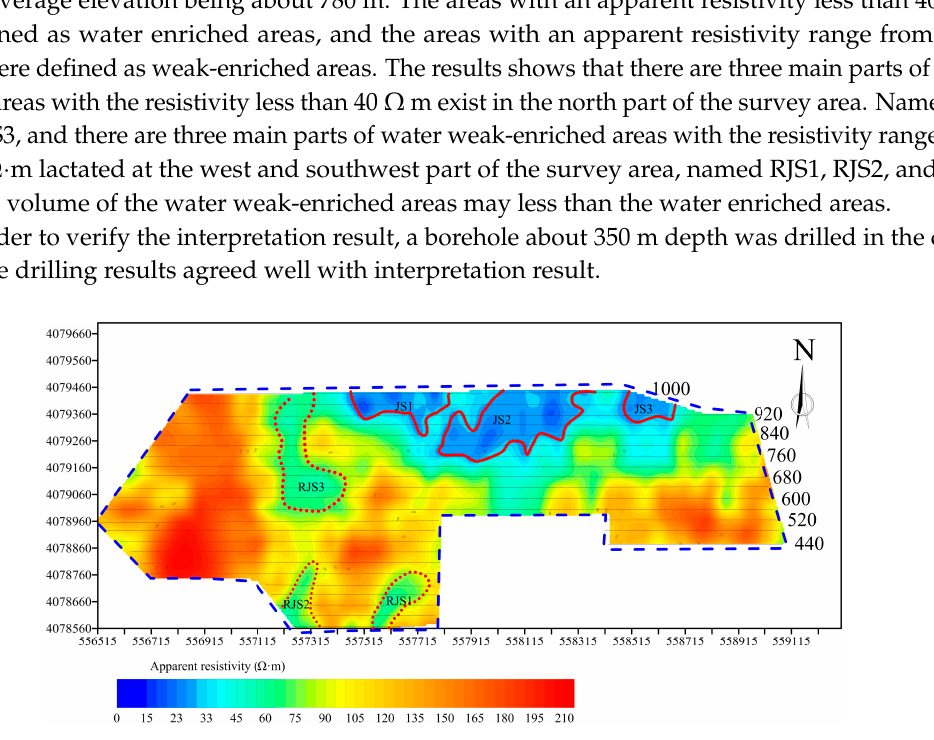
Figure 11. The horizontal slice of the apparent resistivity values of the No. 9 coal bed. The elevation is about 780 m. The areas with an apparent resistivity less than 40 Ω · m were defined as water enriched areas, and the areas with an apparent resistivity range from 50 to 90 Ω · m were defined as water weak-enriched